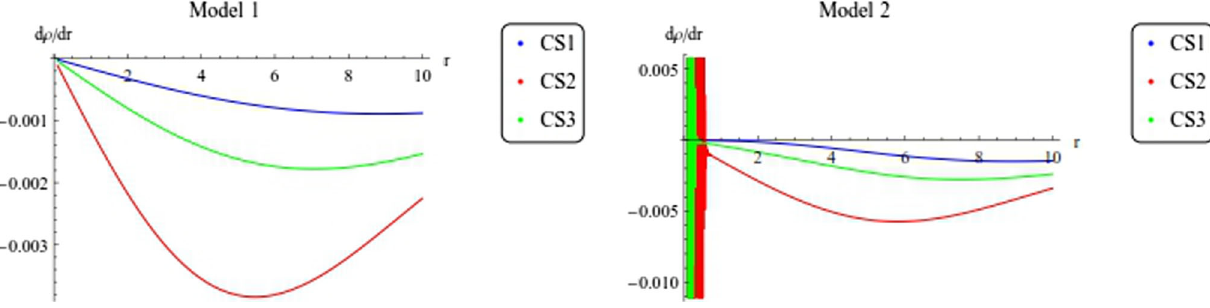
Fig. 4 Graph describing d ρ/ dr with respect to r for both f ( R )